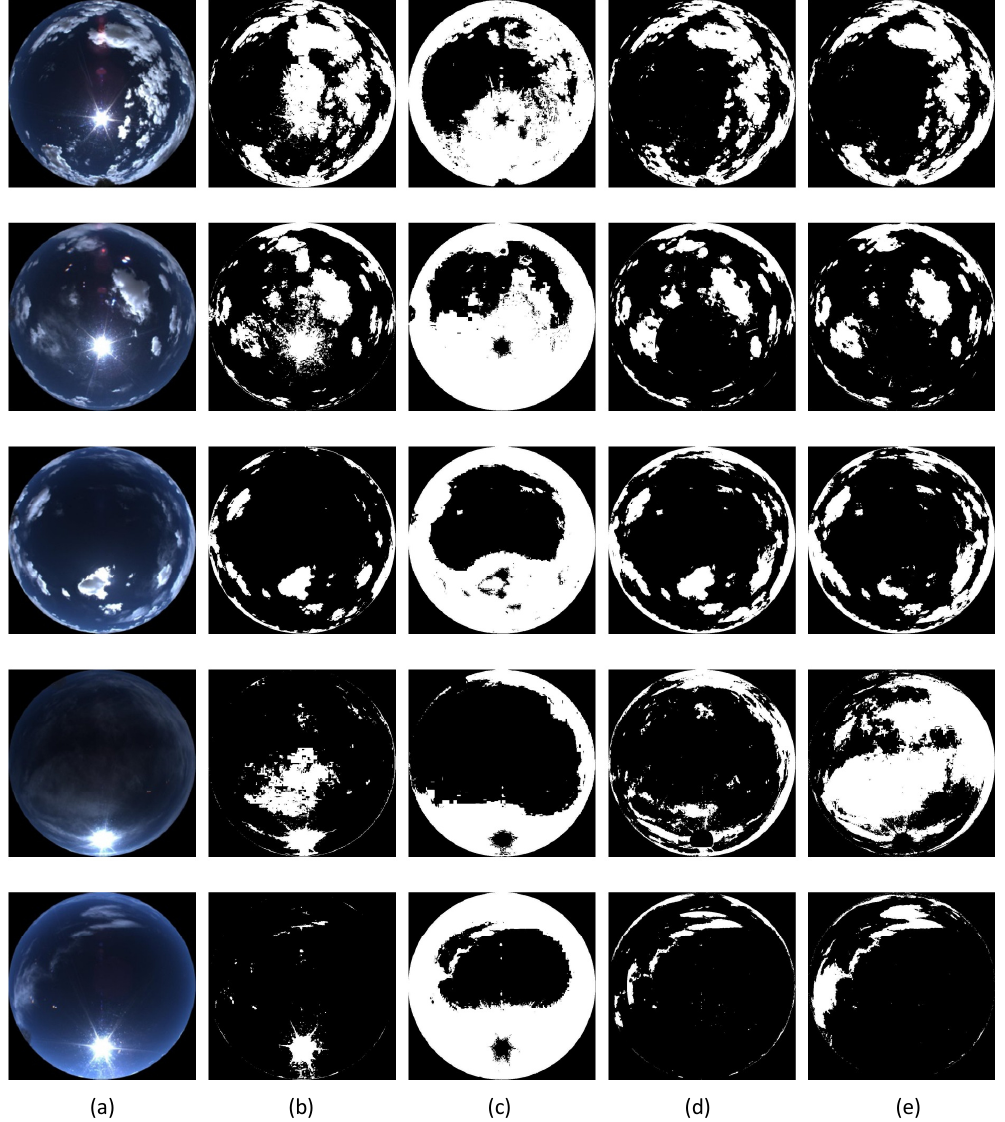
Figure 10. Comparison of different cloud detection methods. Column (a) shows the TCI images after rotation, (b) represents the results of R/B, (c) shows the results of multicolor method, (d) denotes the results of GBSAT, and (e) shows the results of the proposed CSBD method.